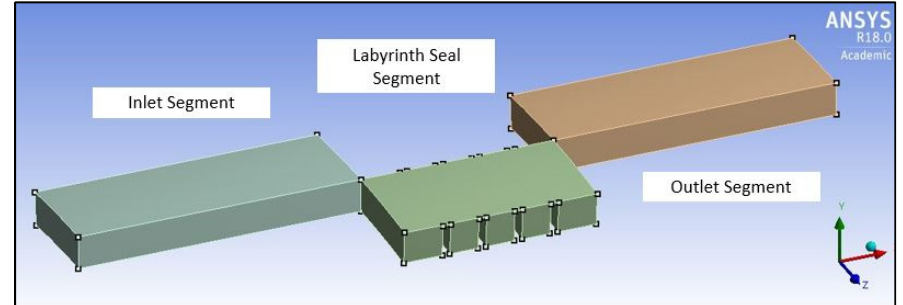
Figure 1. Considered setup with rotor labyrinth teeth.